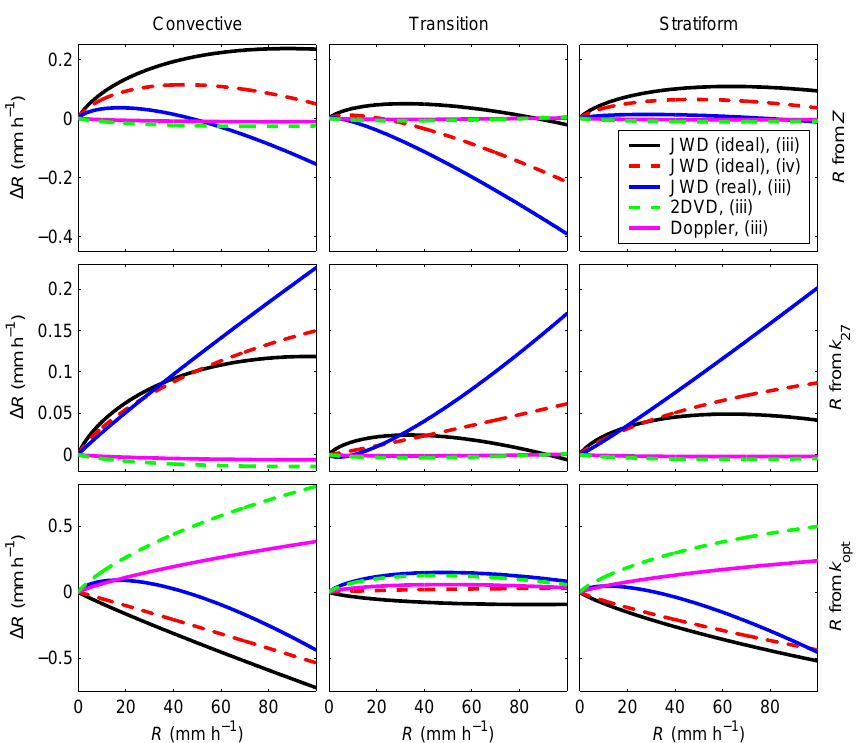
Fig. 7. Errors in the rainfall intensity ( 1R ) resulting from the use of an inappropriate retrieval relation (see Table 3) as a function of true R for Z − R relations (top panels), k 27 − R relations (middle panels), and k opt − R relations (bottom panels). Results for relations based on DSDs from a JWD with infinitesimal diameter classes (ideal), a JWD with real diameter classes, a 2DVD and a vertically-pointing Doppler radar are shown. The effect of turbulence-induced velocity variations is also shown for the ideal JWD (distribution